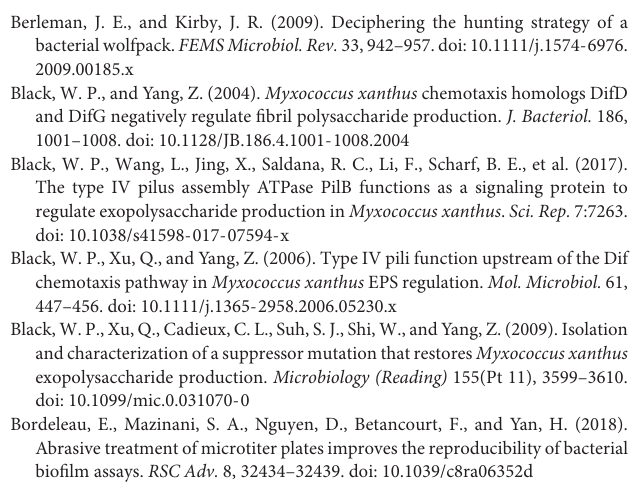
Supplementary Figure 1 | Linear range of A cv with CV concentrations. A cv of CV solutions at indicated concentrations in parts per million (ppm) was measured by an Infinite F200 PRO plate reader. Shown are the averages with standard deviation from three independent experiments, each conducted in quadruplicates. A trendline is shown with an R 2 value of 0.9977 for CV concentrations up to 60 ppm. The inset shows the dataset with CV concentrations up to 30 ppm with an R 2 value of 0.9999 for the trend line. Supplementary Figure 2 | Representative images of PBF formation at the liquid-air interface. 125 µ l of DK1622 (WT) cell suspension at indicated OD 600 was placed in the microwells of a 96-well microplate in triplicates per column. The plate was incubated under static conditions at 32 ◦ C. All microwells in the top row were slightly disturbed by pipette tips to be more wrinkly to aid the visualization of PBFs. Supplementary Figure 3 | SBF formation with aeration. Shown here is the full dataset for Figure 3A . Supplementary Figure 4 | SBF formation at 27 and 32 ◦ C. The full dataset for Figure 4 . Culture volumes are indicated on the top for all panels with the starting OD 600 shown on the X -axis for all graphs. (A) SBF ( A cv ) at 27 or 32 ◦ C. (B) Final optical density (OD 600 ) of the culture after SBF development. (C) Ratio of SBF amount ( A cv ) to final OD 600 with the values for 32 ◦ C normalized to 1. The asterisk (*) indicate significant differences between the two temperatures ( P -value <